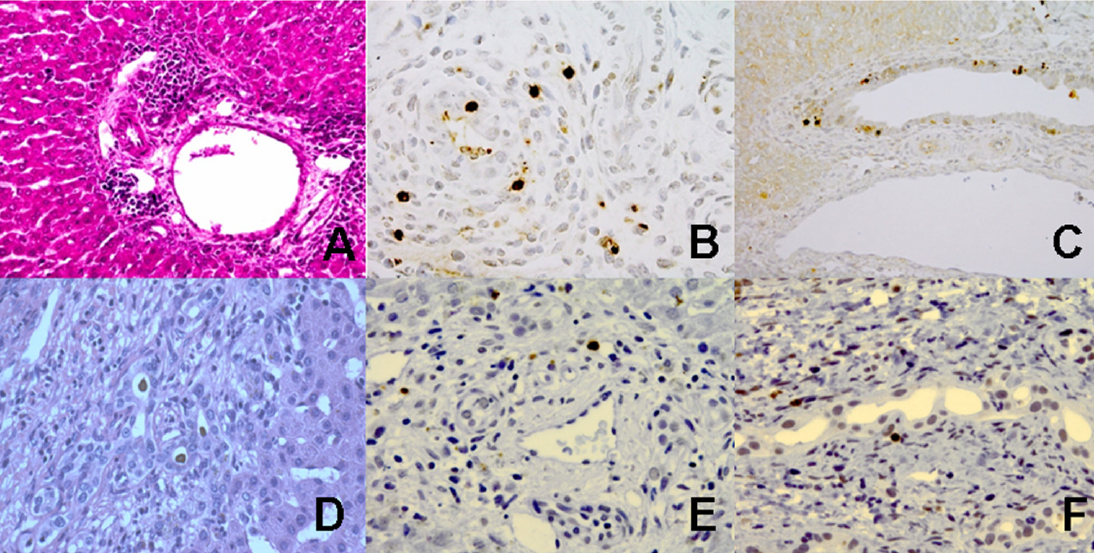
Figure 1. ( A – C : mouse) ( A ) Representative portal tract of a liver section in HE staining, low-power. The genuine bile duct is clearly visible with perifocal mononuclear cell infiltrate. ( B ) Labeling of active caspase-3 and ( C ) TUNEL of a portal tract in high ( B ) or low power ( C ). Positively labeled cells display dark brown color signals in the nuclei. Notice that labeling is restricted to inflammatory by-standers, either perifocal or in the wall of the bile duct. Bile duct epithelium itself does not show specific signals. ( D – F : human) ( D ) Advanced stage of biliary atresia with portal tract fibrosis and neo-ductuli with severe cholestasis, HE staining. ( E ) Labeling of active caspase-3 in neo-ductuli within expanded portal tracts. Staining pattern is similar to TUNEL results ( F ).